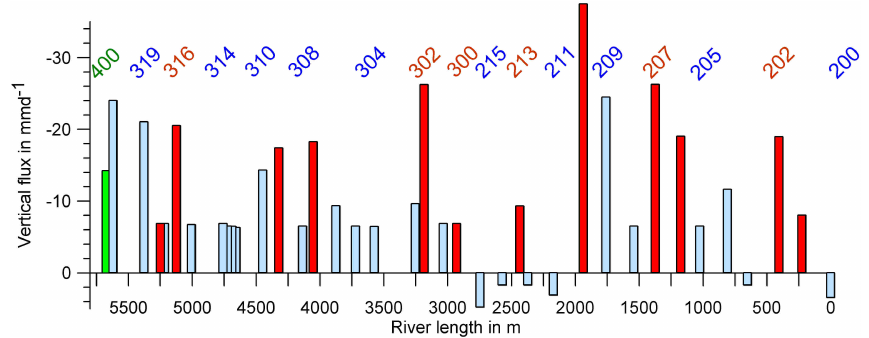
Fig. 7. Results of transient simulations per measurement point with STRIVE. The bars indicate the integrated fluxes per measurement point between 11 October 2007 and 17 June 2008; the colours of the bars indicate soil profiles I, II and III, respectively, in blue, red and